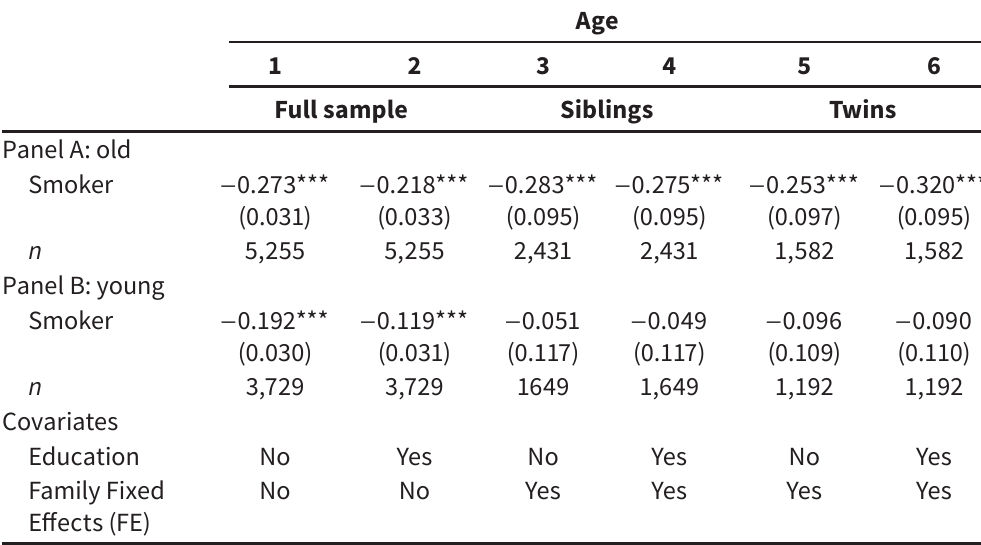
Does the earnings impact vary by